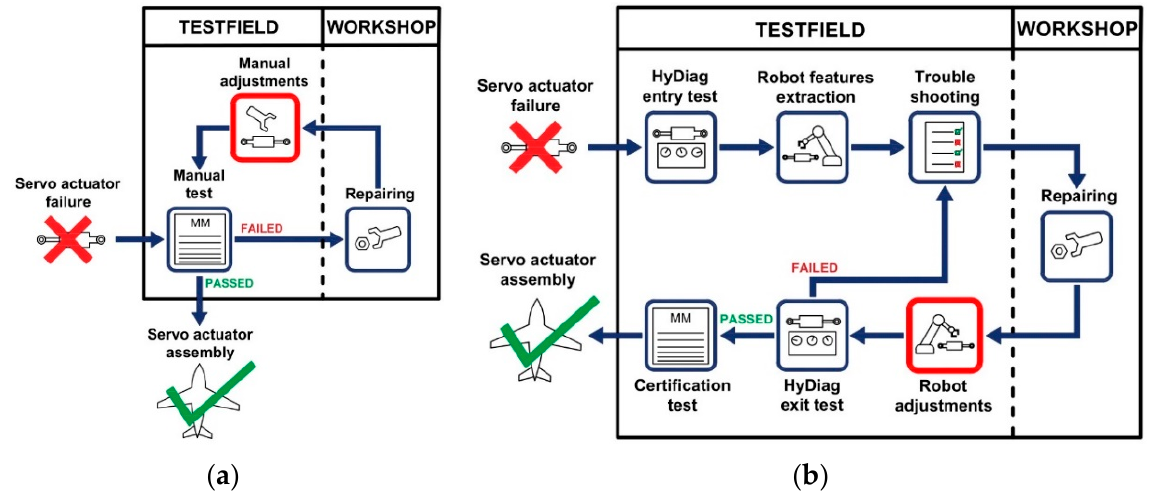
Figure 1. ( a ) Scheme of the actual maintenance procedures for EHSAs adopted by Lufthansa Technik AG; ( b ) Scheme of the enhanced maintenance procedures for EHSAs developed in the HyDiag project.